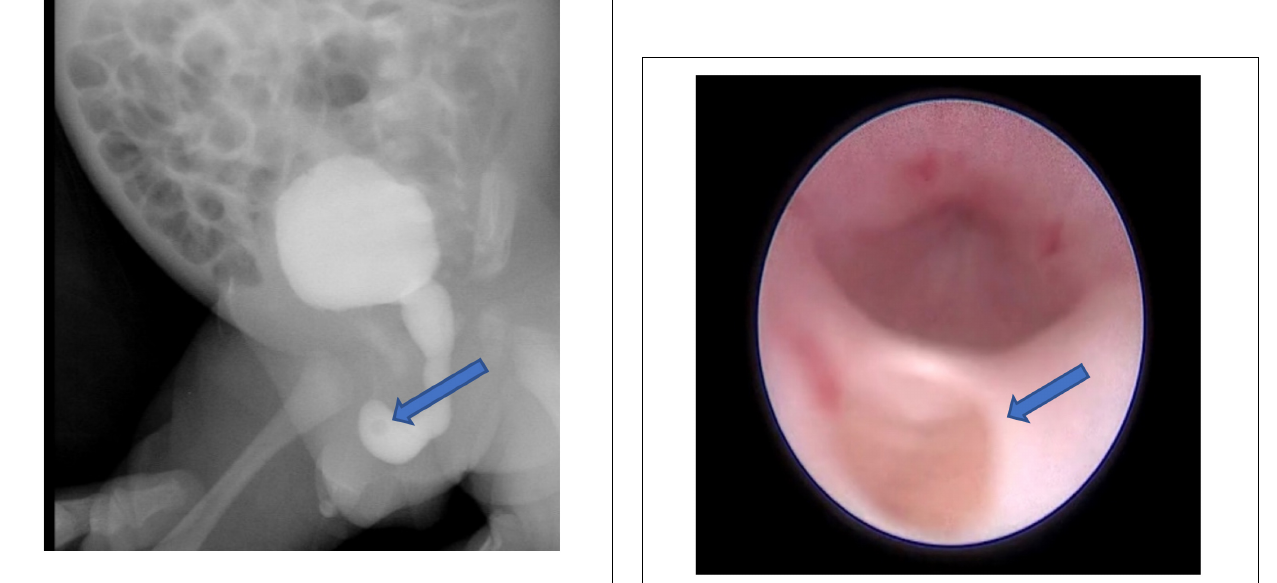
FIGURE 4 | The endoscopic view showing a cusp-like valve as the distal structure of the diverticulum in the anterior urethra, the arrow points to the diverticulum in the 6 o’clock position of the